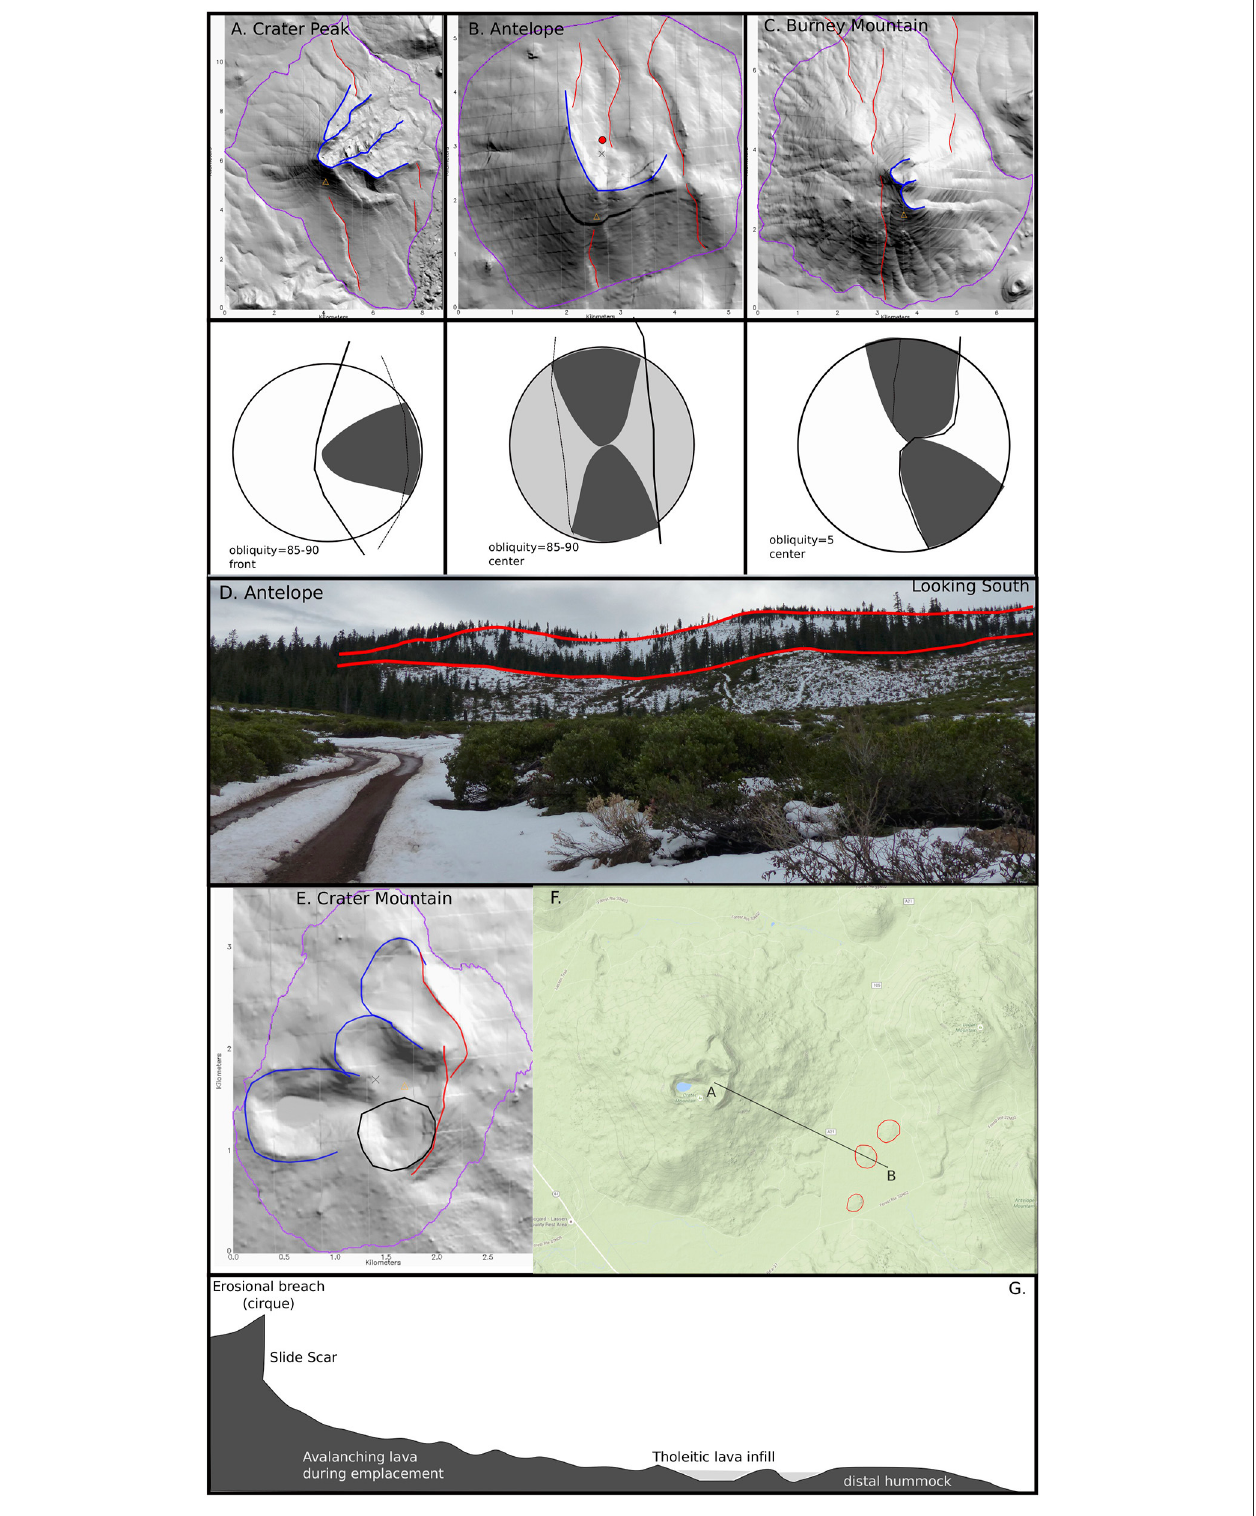
FIGURE 7 | Deformed volcanoes in the Hat Creek Graben region. (A–C) Shaded relief delineated with volcano base (purple), collapse scars or erosional breaches (blue) and structural lineaments (red) for Crater Peak (B) , and Antelope (C) , and Burney (D) Mountains compared with their predictive model cones by Wooller et al. (2009) underneath, where the gray circles represent the edifice; solid lines are main normal faults; dotted polylines are antithetic and minor faults; and gray